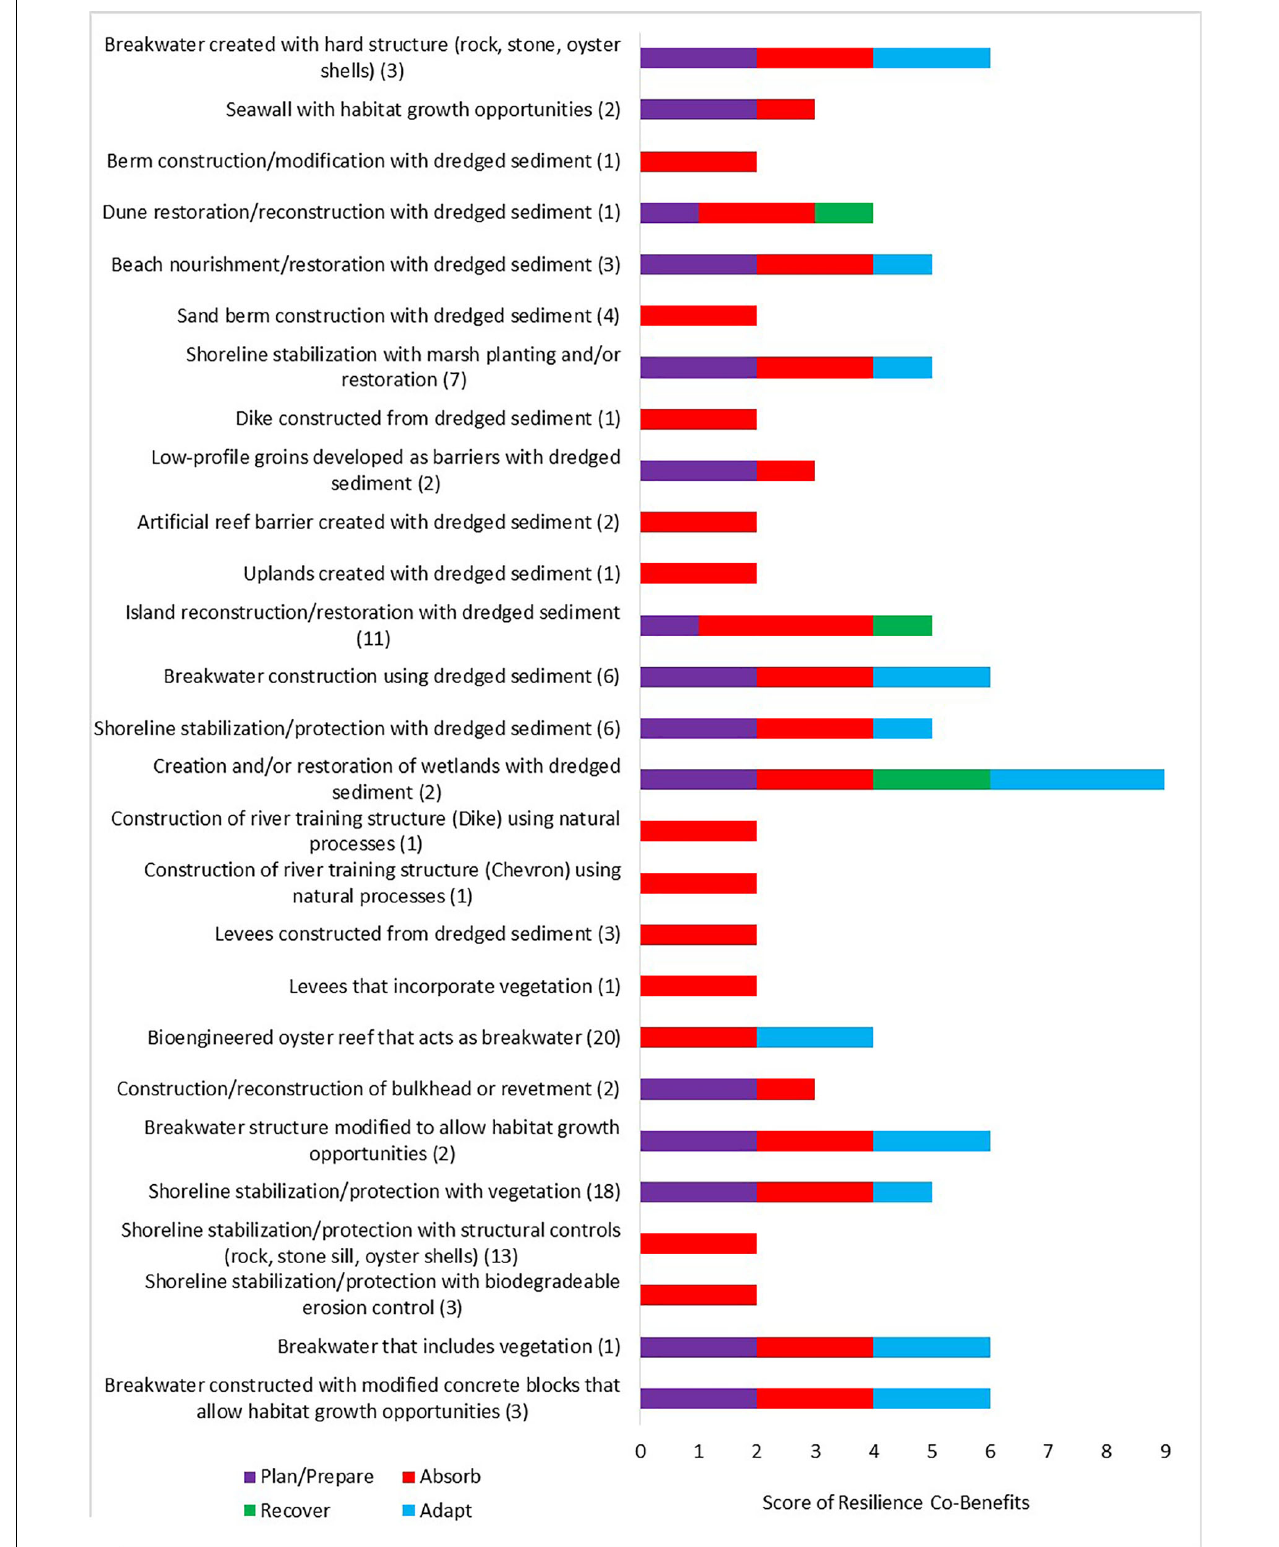
FIGURE 1 | Resilience scores of EWN features types. Number in parentheses indicates how many projects were classified as being of that feature type.